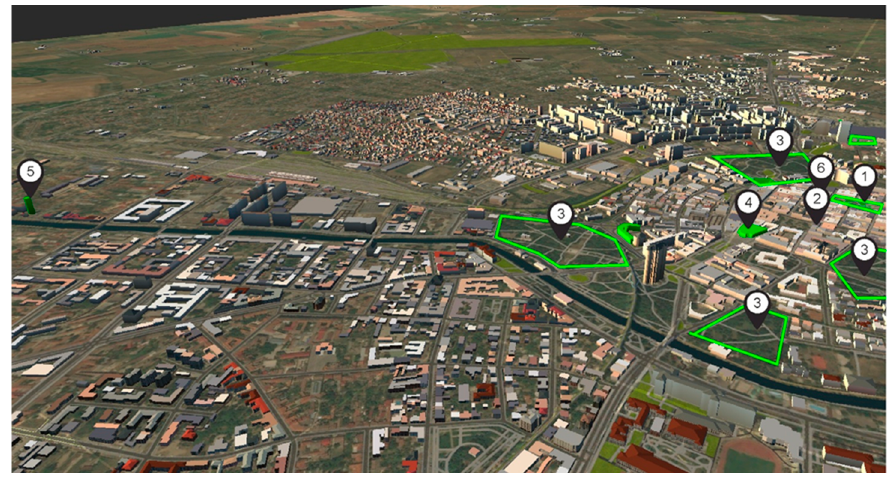
Figure 6. Visual model of Timisoara with an indication of places and spaces where young people gather.